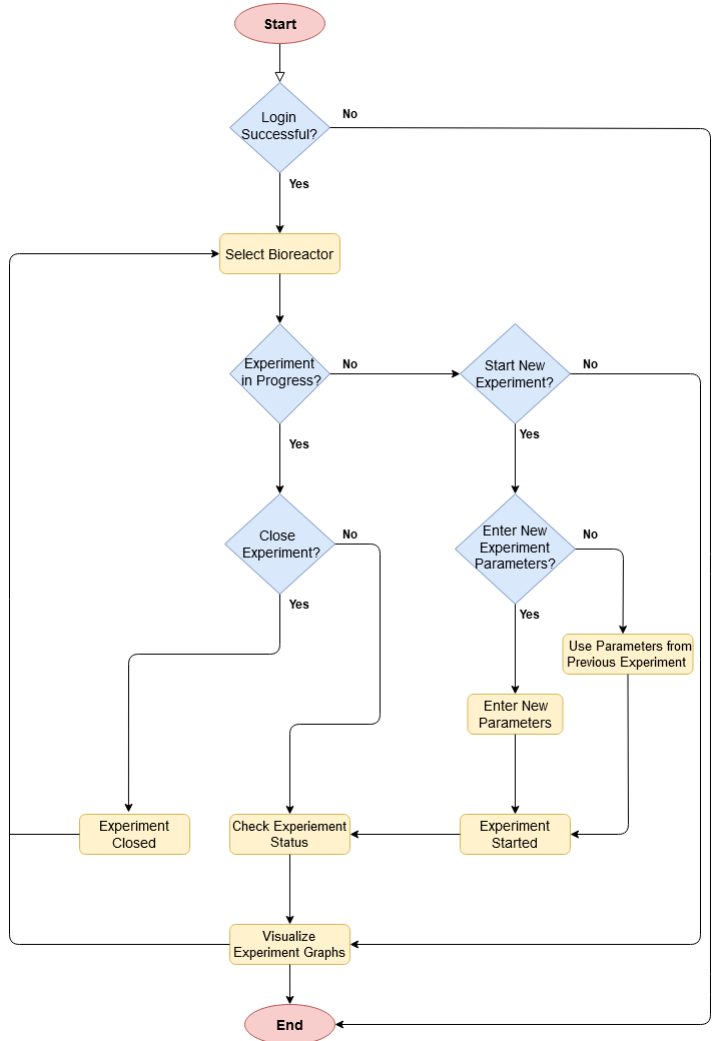
Figure 7. Source code algorithm of the mobile